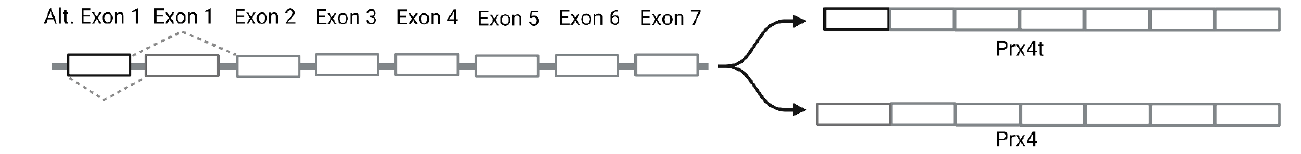
Figure 2. Schematic representation of alternative splicing of Prx4. Systemic Prx4 contains exon 1, whereas Prx4t expressed in mature testes contains alternative exon 1.